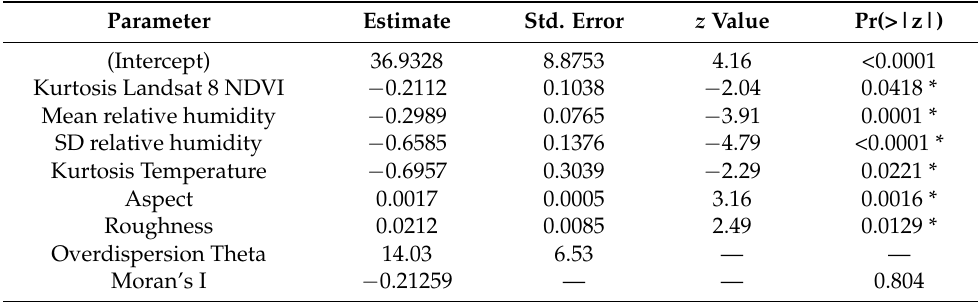
Table 3. Parameter estimates for the best negative binomial model explaining Tripteroides bambusa pupae abundance at Mt. Konpira, Nagasaki, Japan.